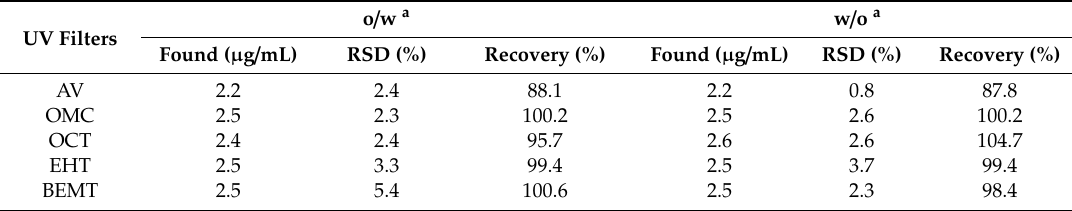
Figure 3. Chromatograms of ( a ) the home-made sunscreen (w/o) (blue), ( b ) the UV filters extracted from the stratum corneum of subject 4 without (green), and ( c ) with the application of home-made sunscreen (w/o) for 0.5 h (red). Detection wavelengths: 300 nm (solid line); 350 nm (dashed line). Peaks: I.S. = 2-VNT, 1 = AV, 2 = OMC, 3 = OCT, 4 = EHT, 5 = BEMT. Table 4. UV filter contents of home-made sunscreens (o/w and w/o) .